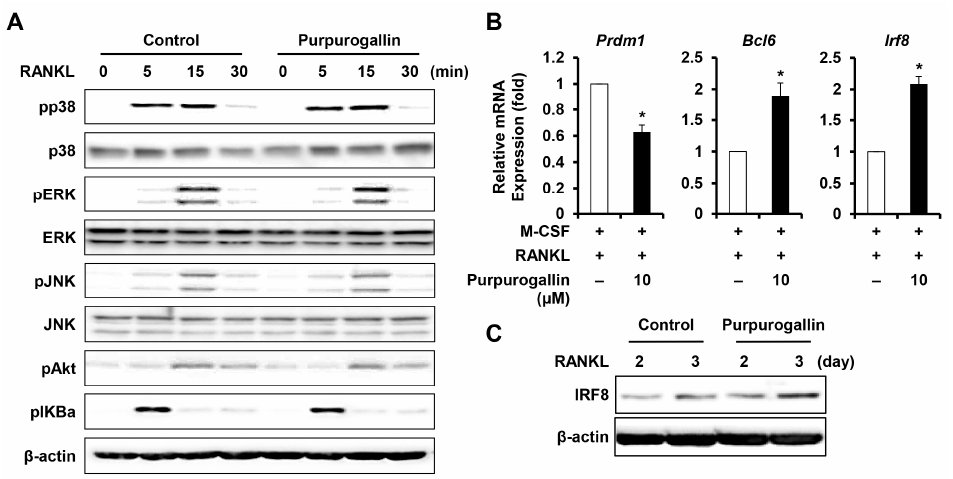
Figure 4. Purpurogallin inhibits the suppression of negative mediators of RANKL-induced osteoclast differentiation. ( A ) BMMs were incubated in a serum-free medium for 5 h, and subsequently pretreated with purpurogallin (10 μ M) or vehicle for 1 h before RANKL (50 ng/mL) stimulation. Phosphorylation of p38, ERK, JNK, Akt, and I κ B α was assessed using western blotting; ( B ) BMMs were incubated in an osteoclastogenic medium with or without purpurogallin for 4 days. The mRNA expression of Prdm1 , Bcl6 , and Irf8 was analyzed using real-time RT-PCR. * p < 0.05; ( C ) BMMs were incubated in an osteoclastogenic medium with or without 10 μ M purpurogallin for the indicated time period. IRF8 protein expression was analyzed using western blotting.